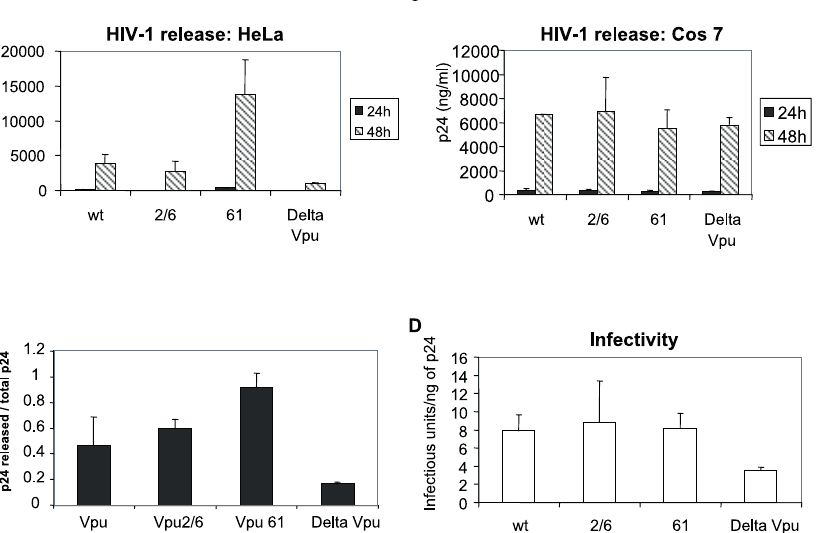
Figure 5. Release of HIV-1 Particles Is Enhanced by Vpu S61 Mutation (A) Vpu S61 mutation enhances HIV-1 release from the Vpu-sensitive HeLa cells. HeLa cells were transfected with 0.5 l g of the indicated HIV-1 proviral DNAs. Capsid p24 antigen was quantified in culture cell supernatants 24 and 48 h after transfection. (B) The tranfected cells described in (A) were lyzed 48 h post-transfection and analyzed for their capsid p24 content. The graph represents the ratios of released p24 released over total p24 amount (released þ internal), 48 h post-transfection. (C) Vpu S61 mutation has no effect on HIV-1 release from the Vpu-insensitive Cos 7 cells. Release was studied in Cos 7 cells as indicated in (A). (D) Vpu S61 mutation does not alter HIV-1 infectivity. The indicated viruses were produced in Hela cells (A) and their infectivity was assayed in Magi cells. Results are expressed as the ratios of infectious particles in Magi cells per ng of p24 capsid protein in the input virus.